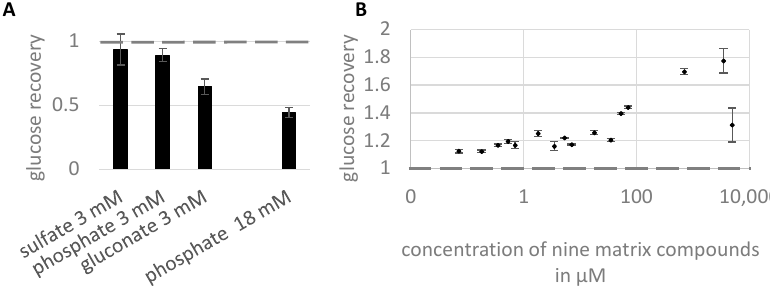
Figure 1. Response behavior of glucose. ( A ) Signal of 20 µ M glucose in the presence of sulfate, phosphate, and gluconate at the given concentration (suppression effect); ( B ) Signal of 7 µ M glucose in a mixture of model compounds (succinate, 2-oxoglutarate, phosphate, erythritol, ribose, fructose, inositol, mannitol, and sinapinic acid) in ascending concentrations (enhancement effect). Note that already for a glucose concentration of 10 µ M, the enhancement effect decreased to a ratio of 1.0–1.4 in the same experiment (not shown). All experiments were conducted using a Trace Focus GC for compound separation.